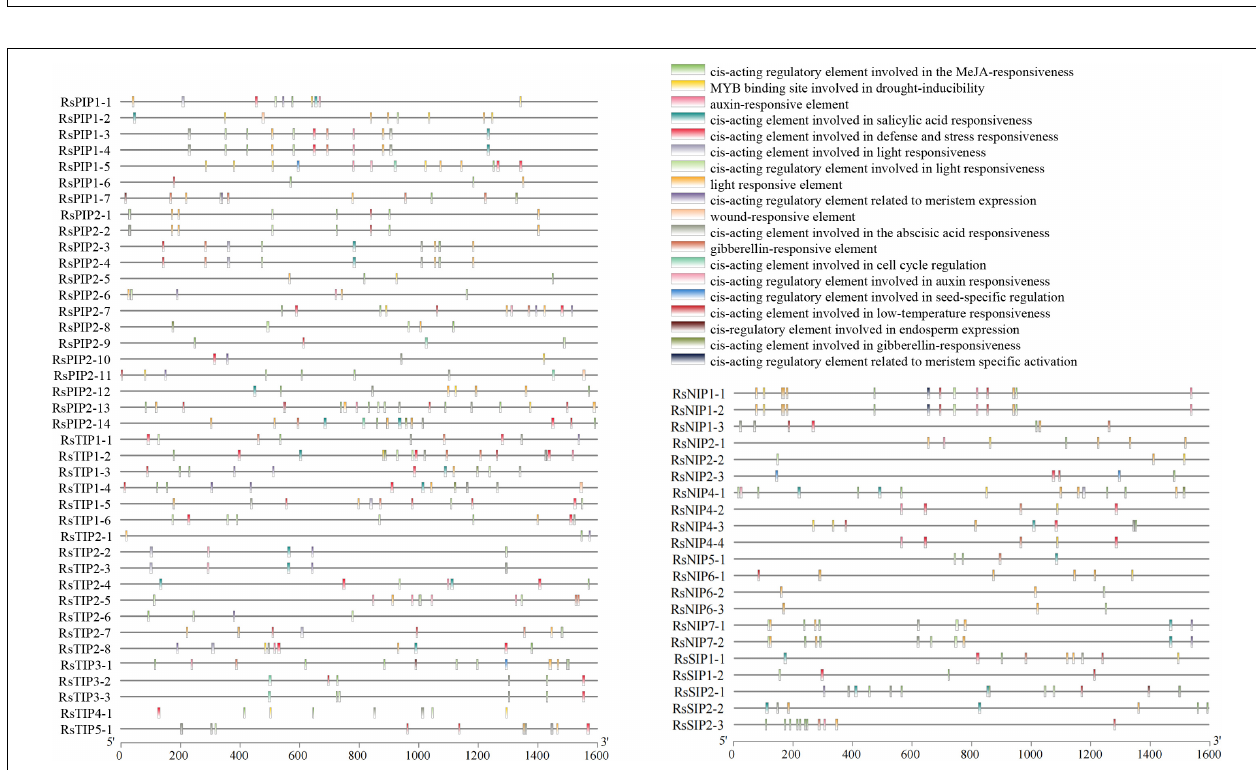
FIGURE 2 | Conserved motifs and gene structure distribution of RsAQP proteins. (A) Phylogenetic tree of RsAQP proteins. (B) Exon–intron structure of AQP genes in radish. (C) Conserved motif distribution of RsAQP proteins.